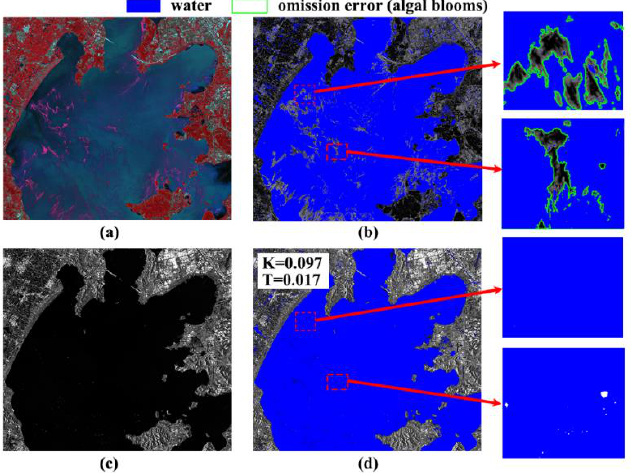
Figure 9. Results of the water extraction in Taihu Lake under algal bloom conditions: ( a ) Optical image. ( b ) Water extraction based on the NDWI. ( c ) SAR image. ( d ) Water extraction based on the SOWI.